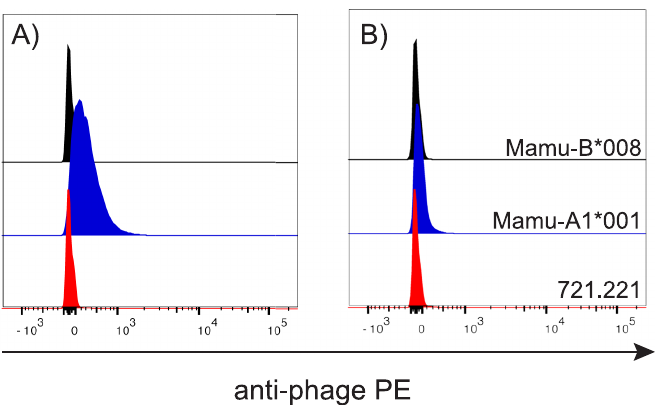
Fig 3. Testing the specificity of Mamu-A1 * 001-panned phages with MHC class I transferents. Mamu- A1 * 001-panned phageclones were incubatedwith the MHC class I-null cell line 721.221and with MHC class I transferents expressingMamu-A1 * 001 or Mamu-B * 008. Cell-bound phages were detected with PE-labeled anti-M13phage antibody.Representative data from the phage clones that did (A) or did not (B) preferentially bind to Mamu-A1 * 001 transferents are